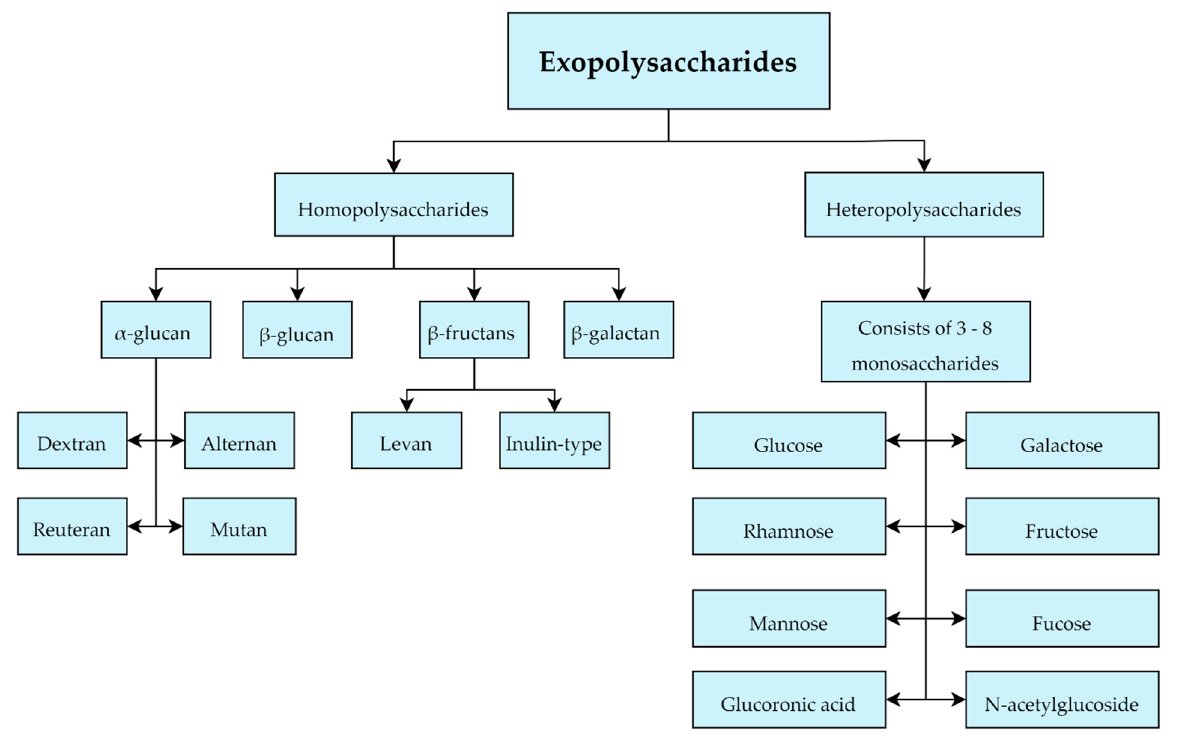
Figure 5. Classification of exopolysaccharides produced by Lactobacillus sp.